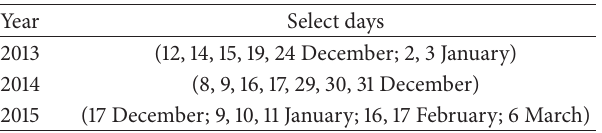
Table1:Dayswiththeoccurrenceofcloudinessduetotheseabreeze convergence over AP for the years 2013, 2014, and